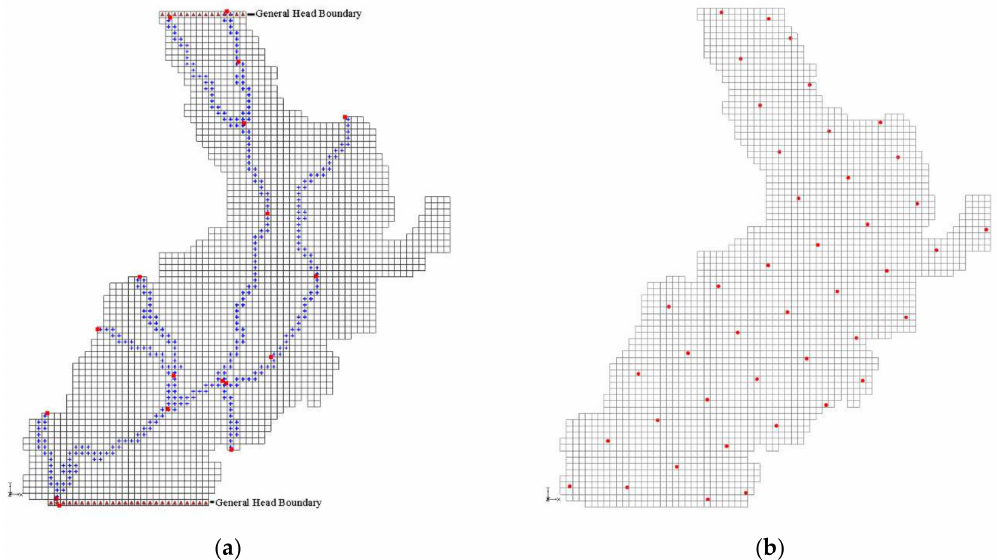
Figure 9. ( a ) Grid blocks for rivers and general-head package and ( b ) locations of regular pilot points used in parameter estimation for spatially variable parameters such as hydraulic conductivities, specific storage, specific yield, recharge, and maximum evapotranspiration